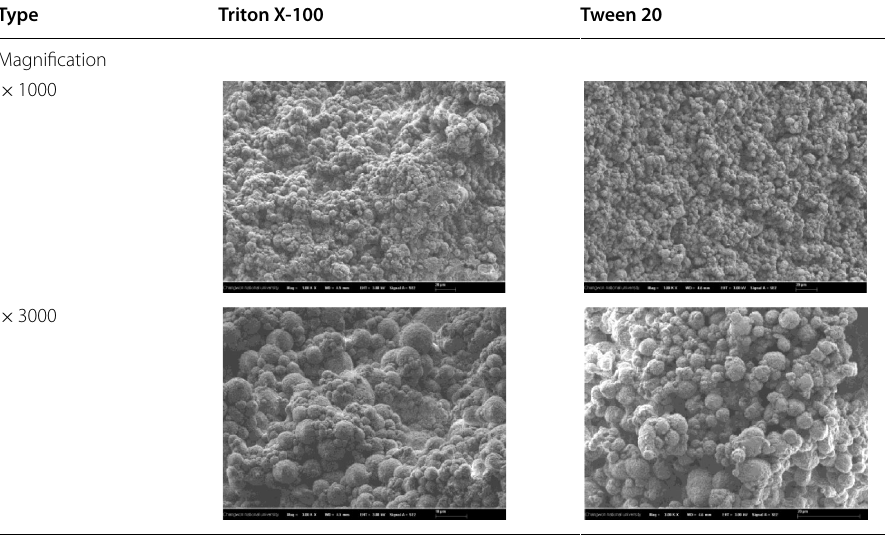
Table 1 Microscope images of synthesized microcapsules according to type of emulsifier